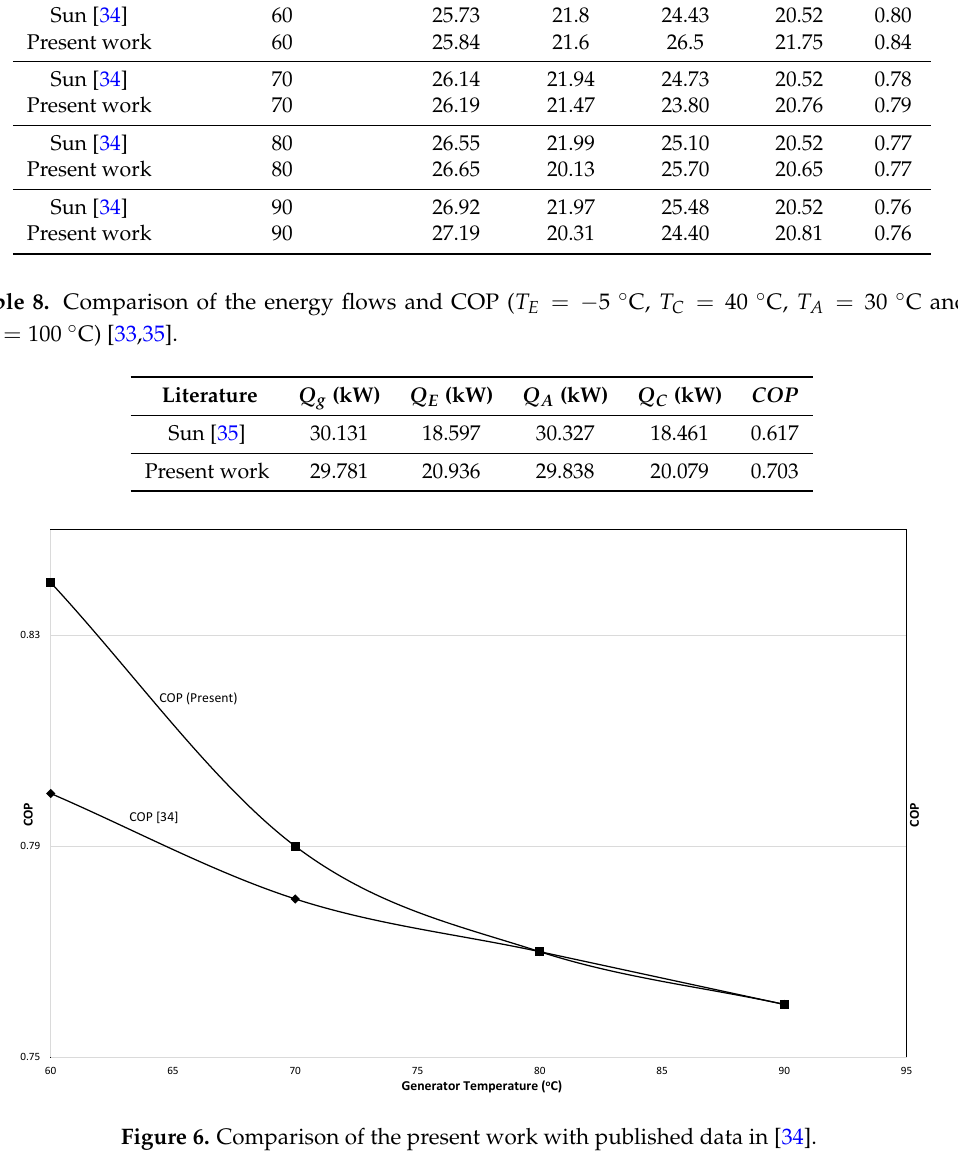
Figure 6. Comparison of the present work with published data in